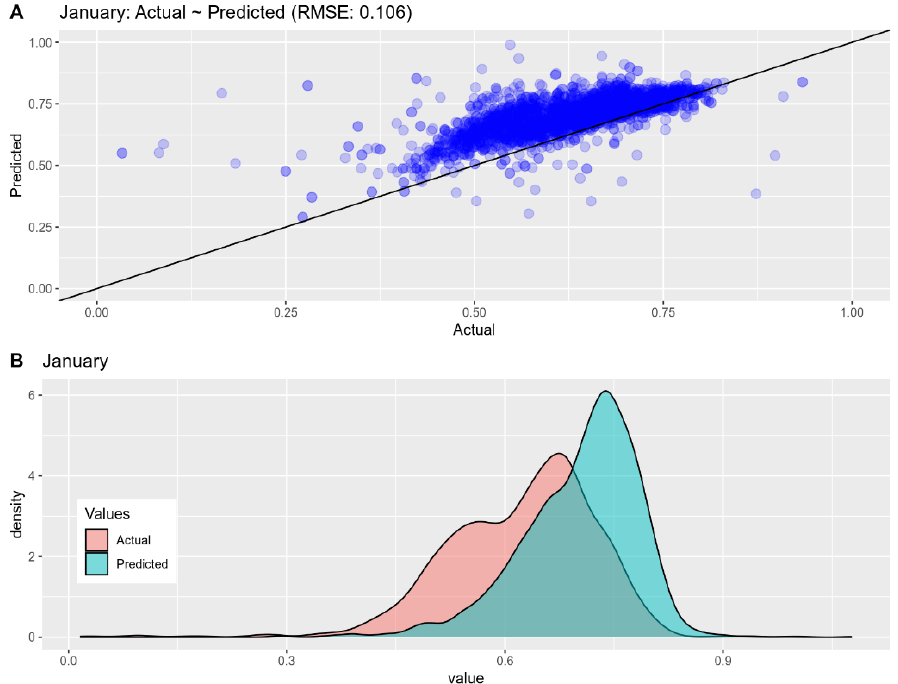
Figure A1. Comparison between actual~predicted for January 2020.